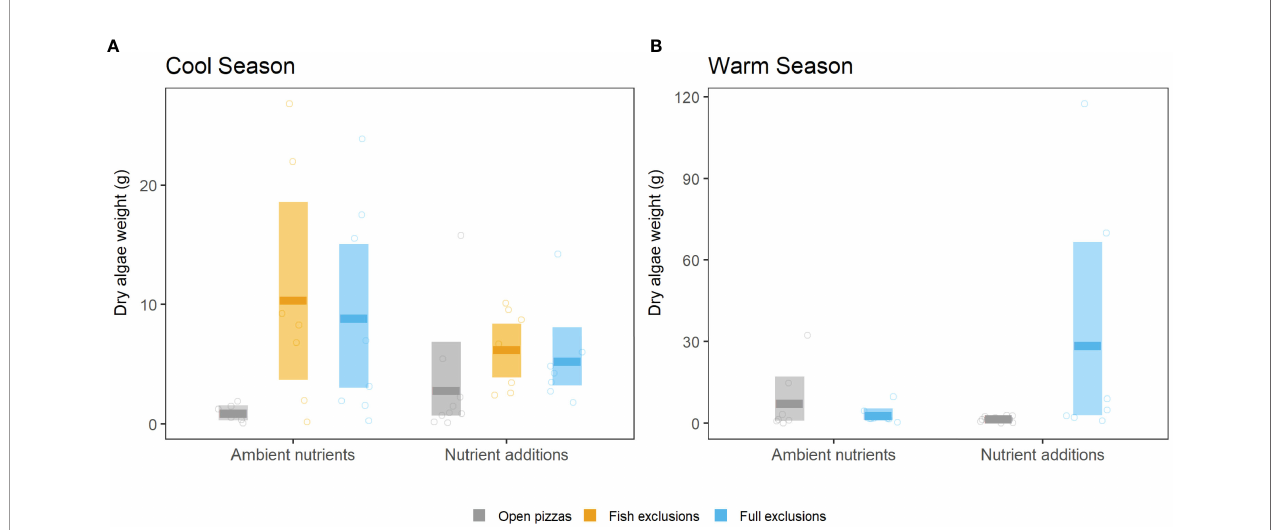
FIGURE 4 | Herbivore treatment effects on fi nal macroalgal biomass (AFDW of all algal taxa, which was largely Ulva ) in the 2019 cool season (A) and the 2020 warm season experiments (B) . Bars represent bootstrap estimated means (darker, thick horizontal lines) and modelled 95% con fi dence intervals (entire shaded bar). Circles are the individual data raw points (n =